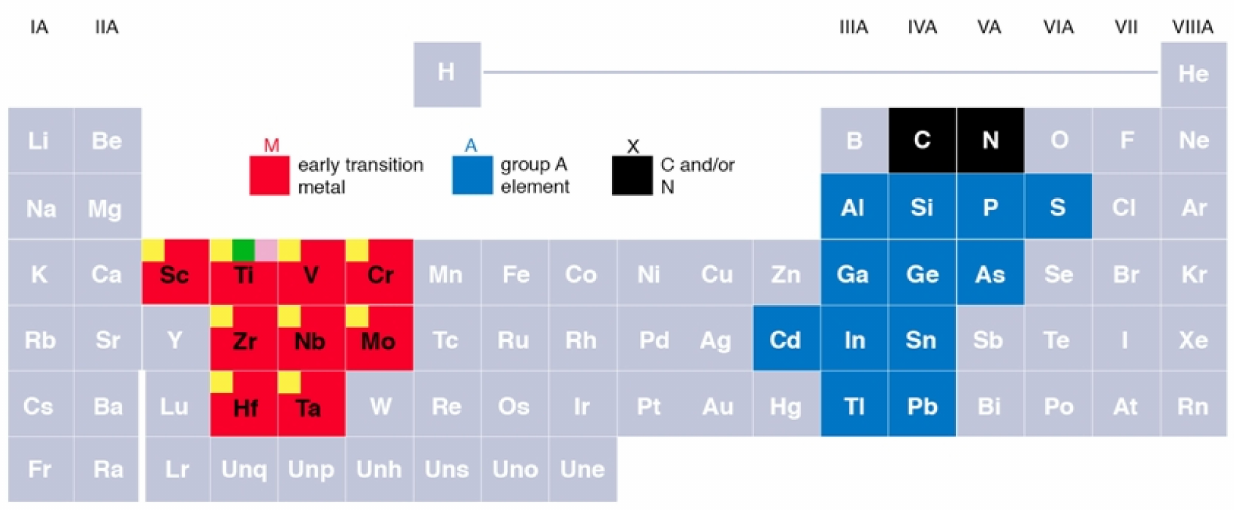
Figure 1. Periodic table depicting the elements required in MAX phase formation. The red boxes denote early transition metal (M), blue boxes denotes group 13 and 14 elements (A), and black boxes denotes carbon or nitrogen (X). Reprinted with permission from ref. [4] (Radovic & Barsoum, 2013), Copyright Radovic; TAMU.American Ceramic Society.